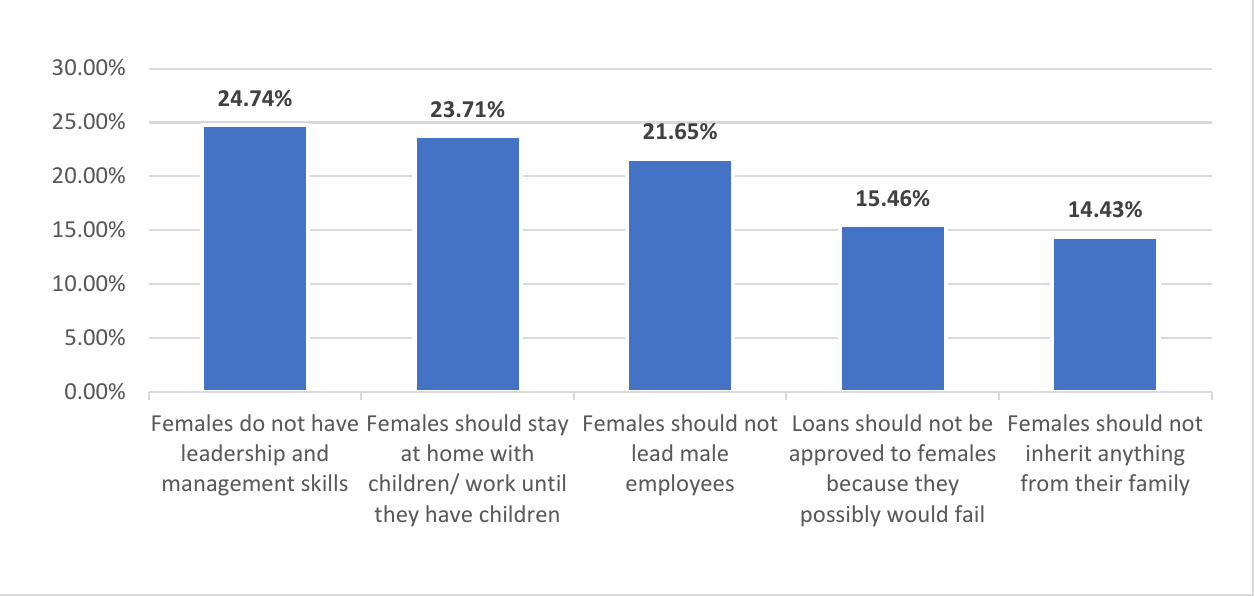
Figure 3. Most discriminatory statements (N = 36). Source: (authors’ own elaboration).